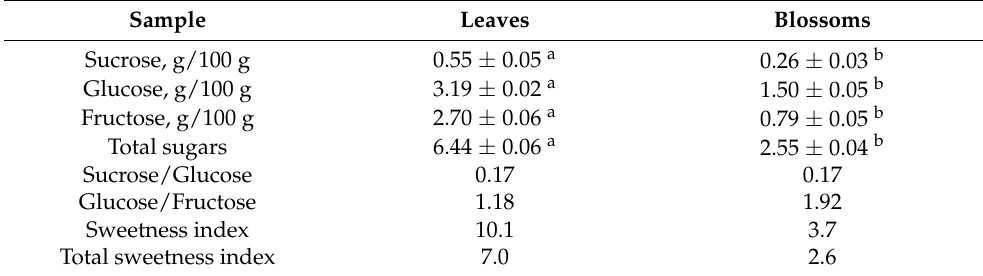
Table 3. Carbohydrate content in samples of Sambucus nigra L. Sample Leaves